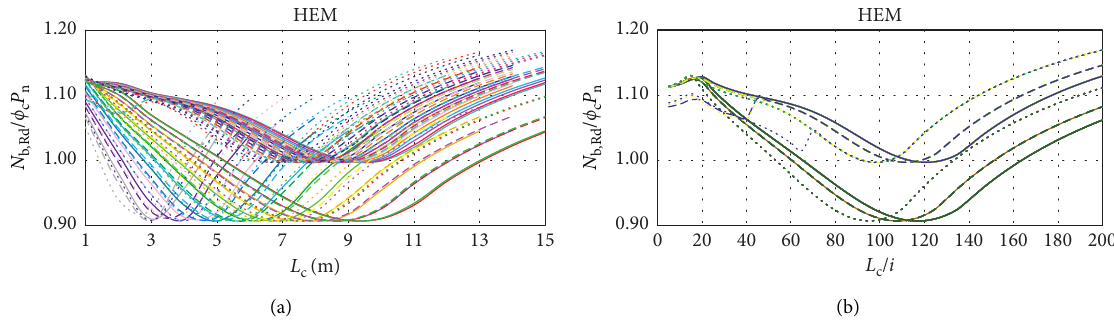
Figure 12: Variation of capacity ratio with buckling length L c (a) and with member slenderness L c / i (b) for studied HEM members. In each plot, the solid, dashed, and dotted curves with identical colours represent the capacity curves plotted for a particular section when the steel grades are S235, S275, and S355, respectively.